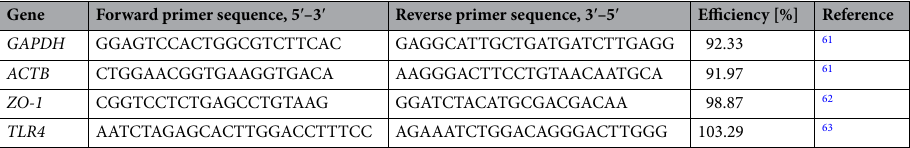
Table 2. Primer sequences used for quantitative real-time polymerase chain reactions (qRT-PCR) and their corresponding primer